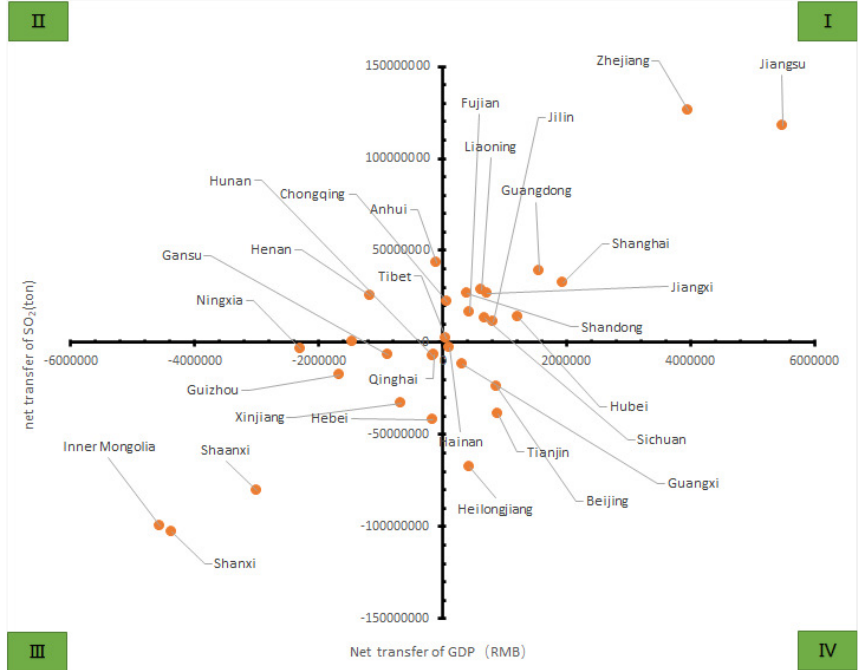
Figure 2. Relationship between net outflow of SO 2 and net outflow of economic benefits from air pollution in China by